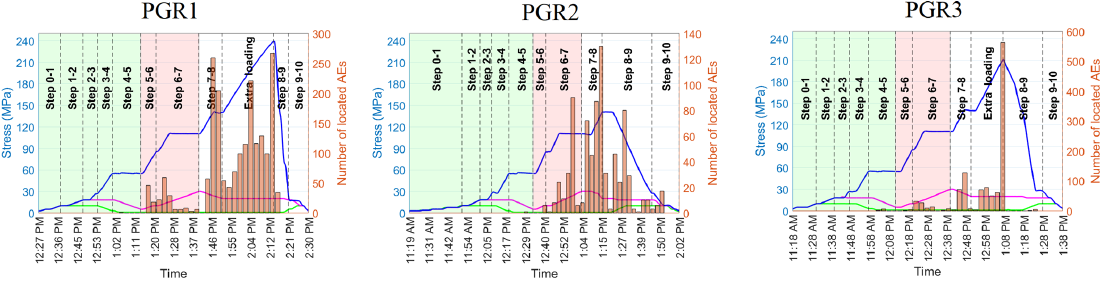
Figure 6. The AE signature in the PGR laboratory samples tested under the state of the true-triaxial experiments. Blue, purple, and green lines represent the maximum, intermediate, and minimum principle components